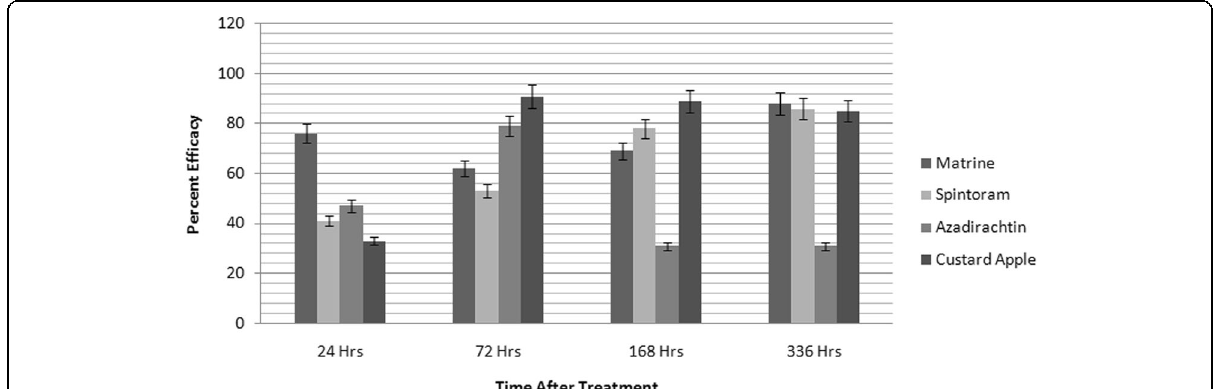
Fig. 2 The percent mortality of Aphis gossypii at different days after spraying in the greenhouse